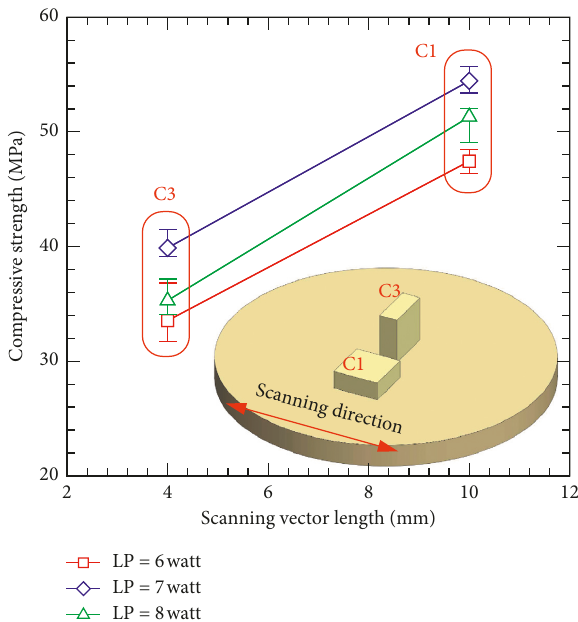
Figure 6: Effect of scanning vector length on the average com- pressive strength of PA12/white cement